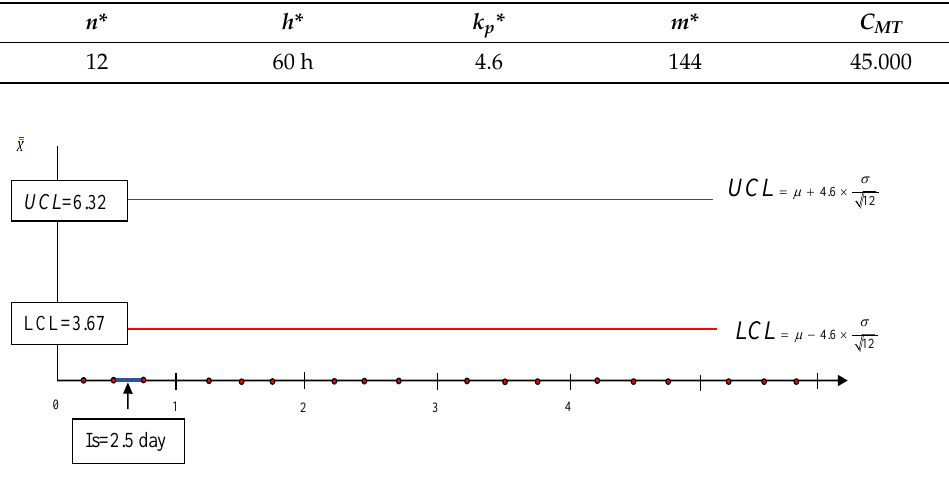
Table 15. Optimal number of preventive maintenance activities ( N =